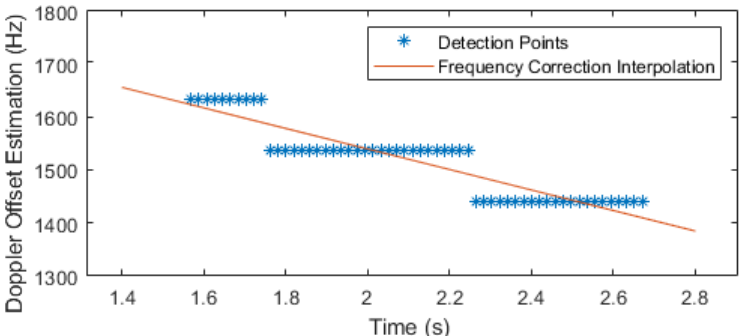
Figure 5. Detection points during one